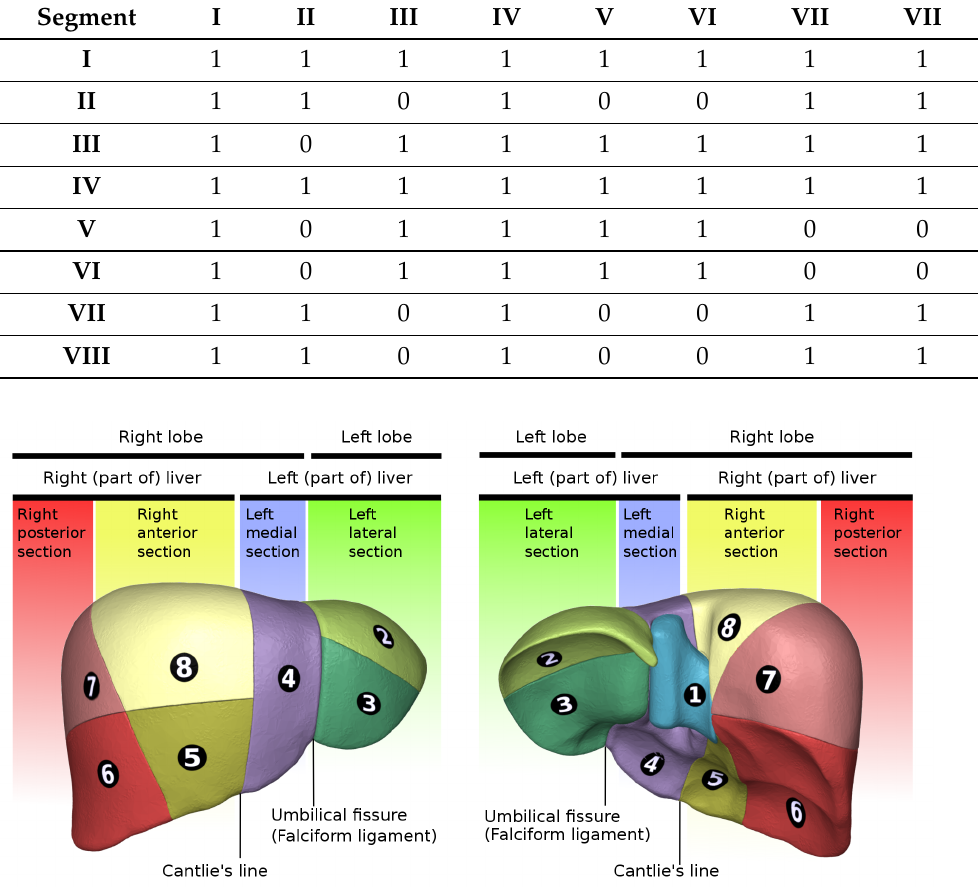
Table 2. Segments’ inconsistency table. If the presence of the pair of segments in the same axial slice is possible, we inserted a “1” into the matrix, otherwise a “0”.